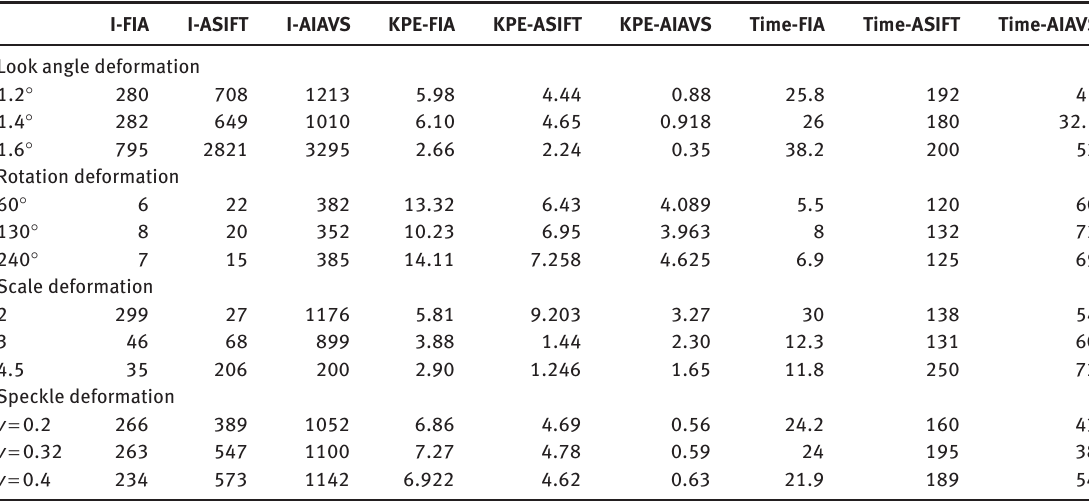
Table 5: Qualitative Assessment of Number of Inliers (I), Key Point Error (KPE), and Time (Seconds) among the FIA, ASIFT, and Proposed AIAVS Approaches.